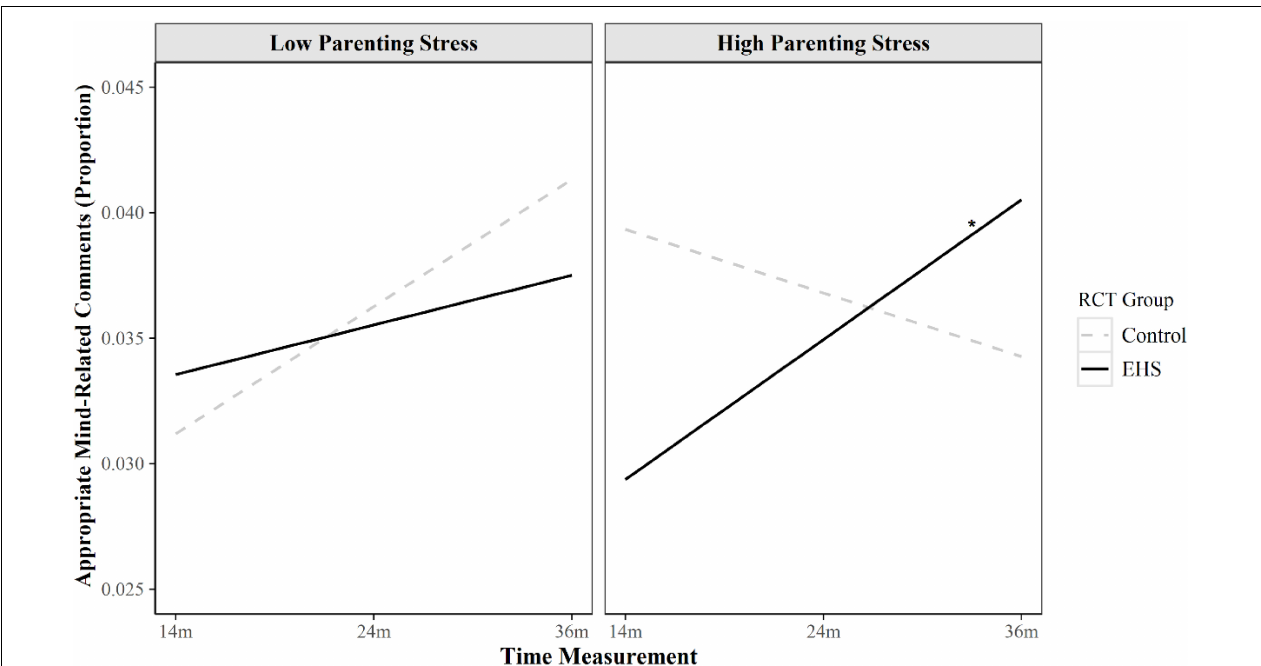
FIGURE 1 | Conditional growth curves of appropriate MRC by RCT group and parenting stress. This figure illustrates trajectories of appropriate MRC over time for mothers in the EHS intervention or control group with low (40th percentile) and high (80th percentile) parenting stress. Among mothers experiencing high parenting stress, those who received infant mental health informed EHS displayed increases in appropriated MRC over time relative to control group. However, among mothers experiencing low parenting stress, there was no significant difference in appropriate MRC growth between EHS and control mothers. * p <